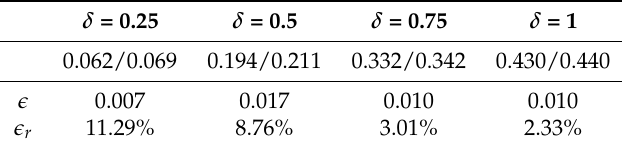
Table 5. Case study II. Traffic Saving Ratio